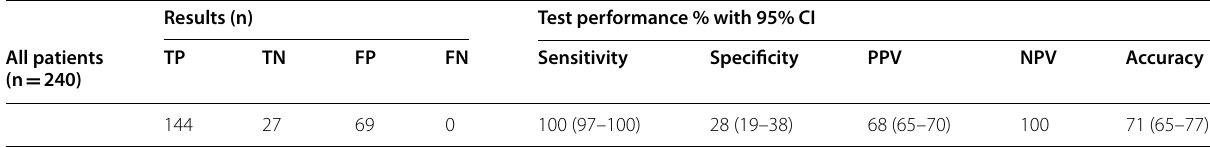
TP true positive, TN true negative, FP false positive, FN false negative, PPV positive predictive value, NPV negative predictive value, CI confidence interval